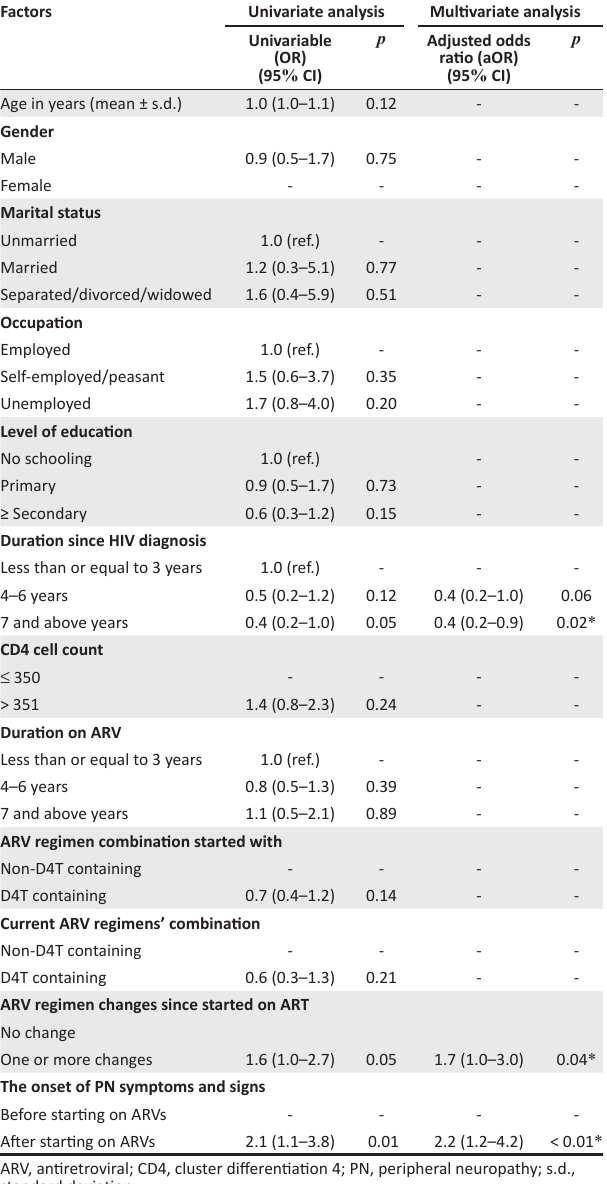
TABLE 2: Generalised linear regression with general estimating equation for the associated and influencing factors of improvement on peripheral neuropathy.